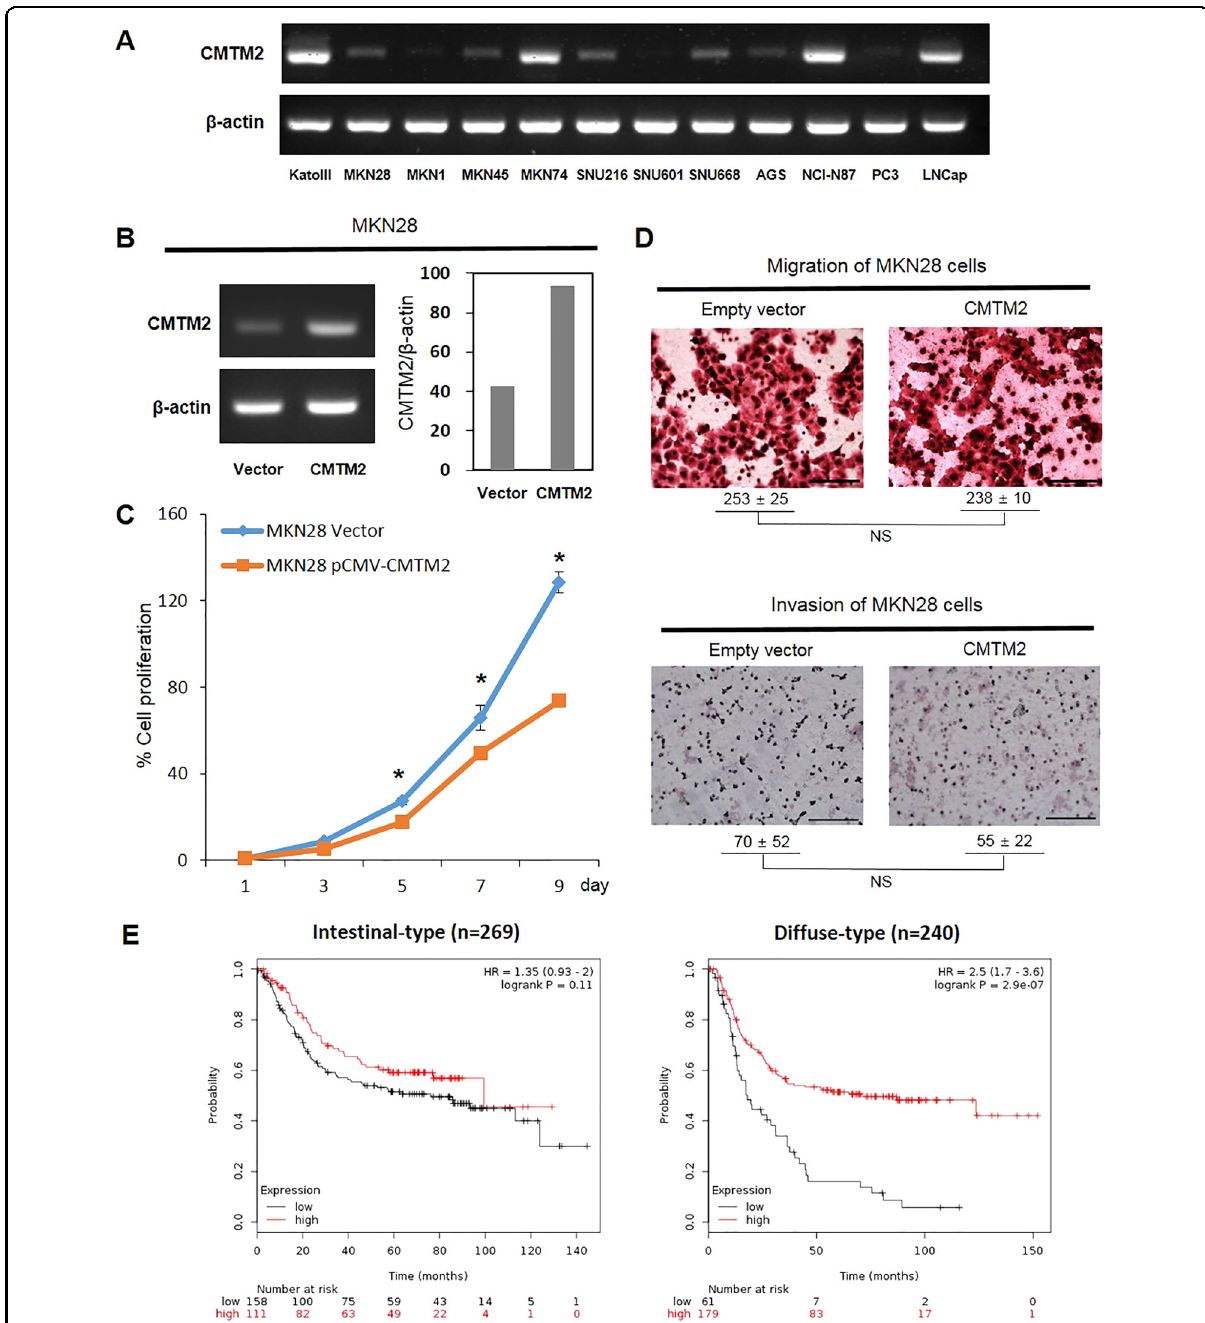
Fig. 2 Functional and clinical signi fi cance of CMTM2 expression. a Expression status of CMTM2 in gastric cancer (GC) cell lines, as detected by nested qRT-PCR. LNCap and PC3 prostate cancer cells were used as positive and negative controls, respectively. b Increased CMTM2 expression in CMTM2 -induced MKN28 cells. c Reduced proliferation of CMTM2 -overexpressing MKN28 cells. d Migration and invasion of CMTM2 -induced and empty vector-induced MKN28 cells. Scale bar, 100 μ m. e Kaplan-Meier survival curves compare the overall survival between the CMTM2 -low group and the CMTM2 -high group for intestinal-type GC ( n = 269, left) and diffuse-type GC ( n = 240, right) cohorts. NS, not signi fi cant. * P <